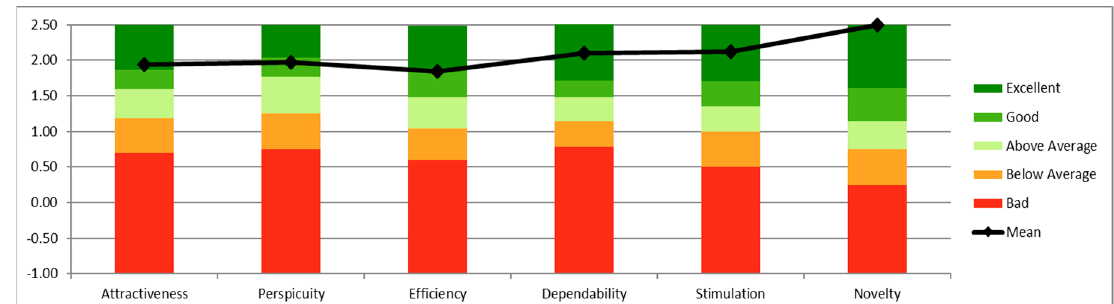
Figure 7. Comparison between means of each UEQ scales and values from a benchmark data set.